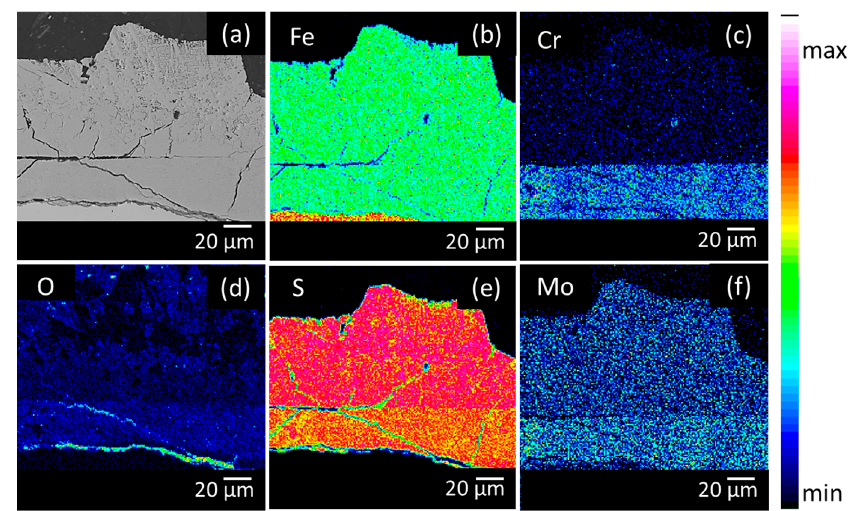
Figure 5. Cross-sectional BSE image ( a ) and elemental mappings of ( b ) Fe, ( c ) Cr, ( d ) O, ( e ) S and ( f ) Mo of the low Mo (B) material after 28 days of immersion in the H 2 S saturated test solution.